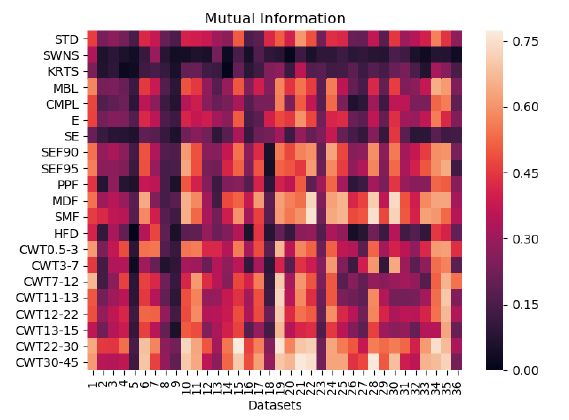
Figure 1. Mutual information between features and corresponding labels for all